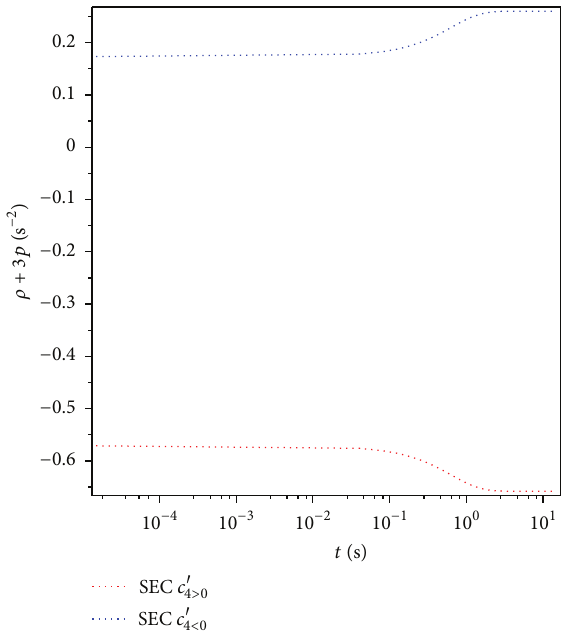
Figure 2: The evolution of SEC for closed model. Here the sign of thethreeconstants 𝑐 󸀠 1 , 𝑐 󸀠 2 ,and 𝑐 󸀠 3 hasnoeffectontheevolutionofSEC; however, 𝑐 󸀠 4 must have negative value to satisfy the